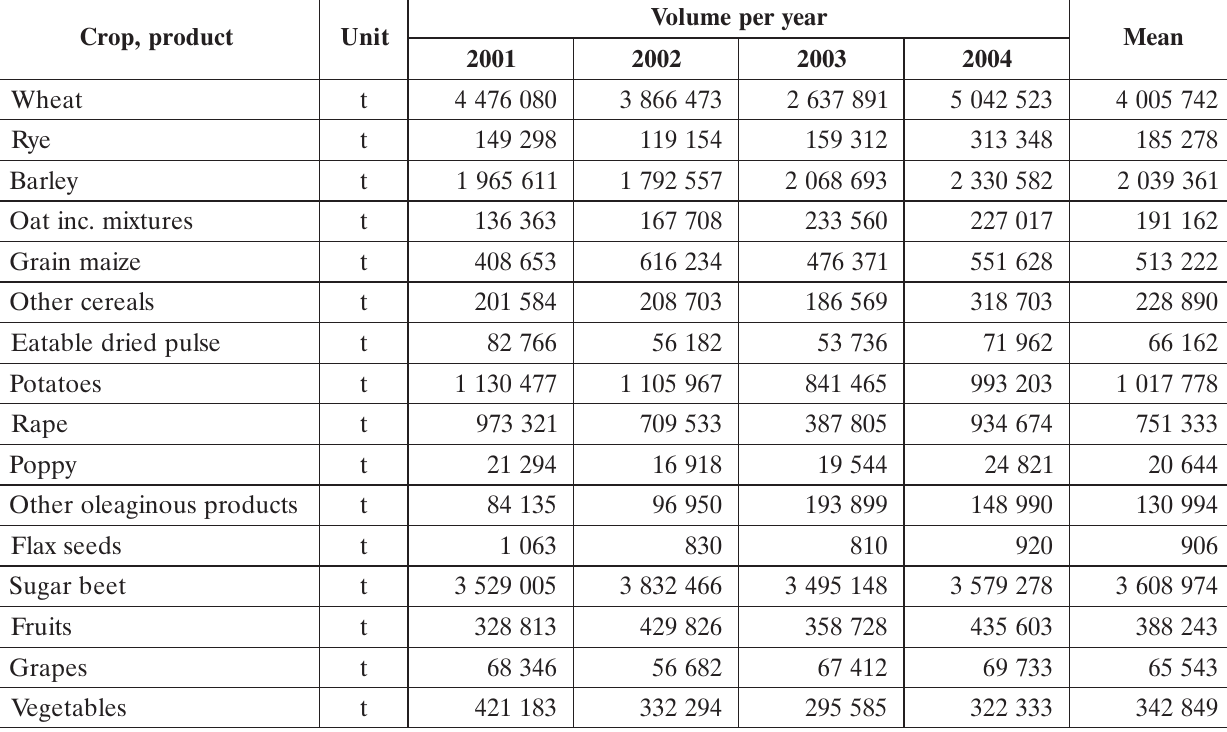
Table 1. Crop Output Total in the Czech